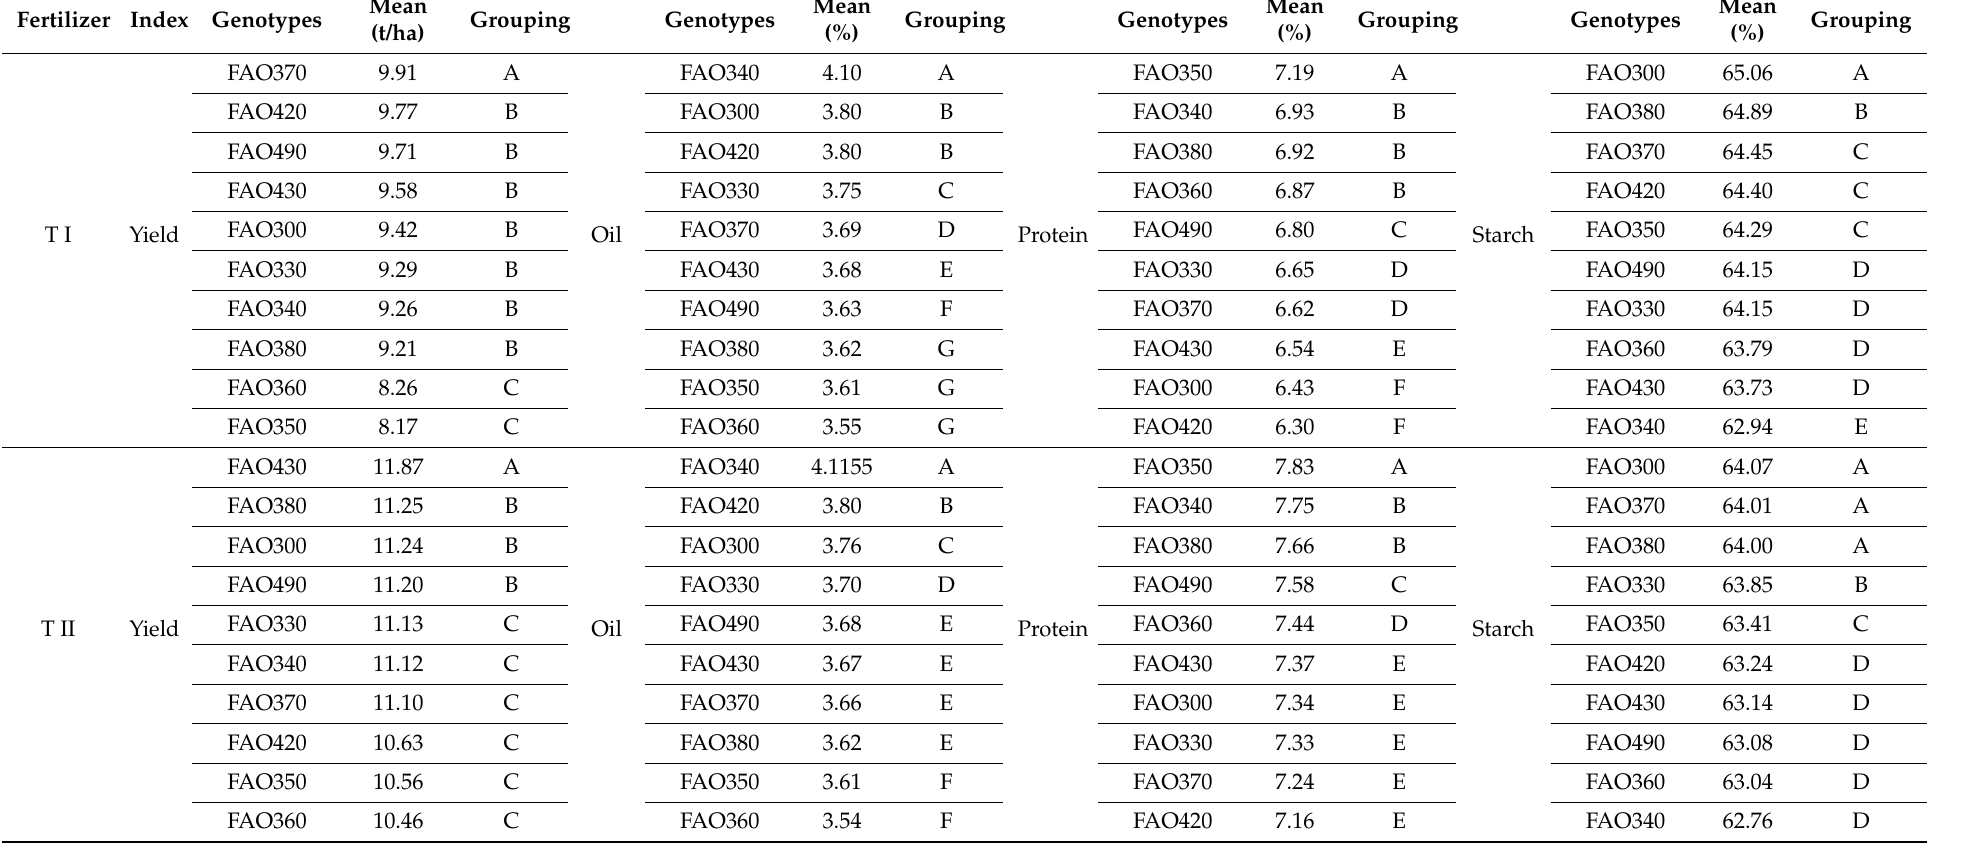
Table 4. Tukey grouping analysis of hybrids in fertilizer